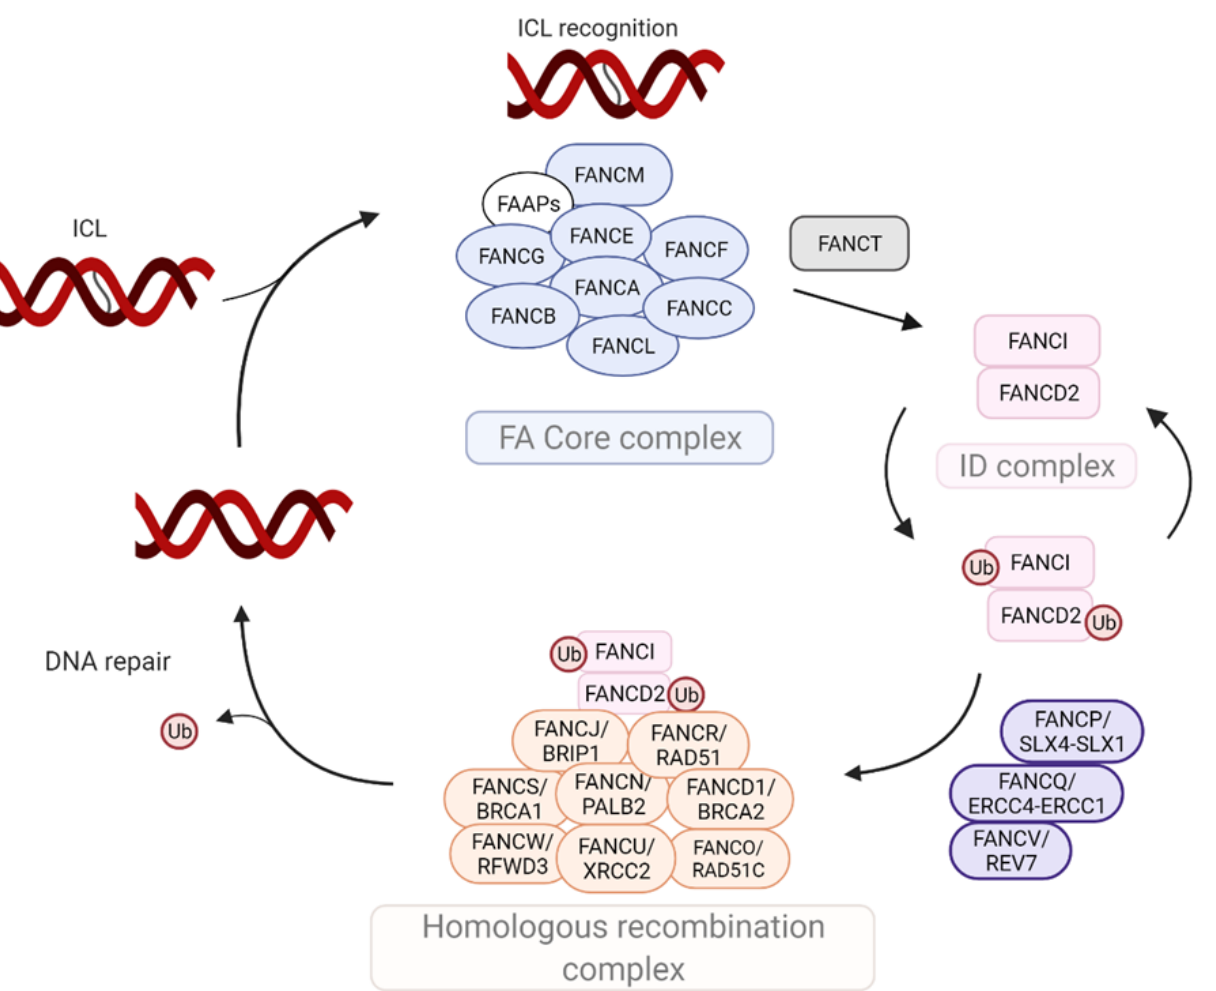
Figure 1. The Fanconi anemia (FA) DNA repair pathway specializes in the repair of DNA interstrand cross-links (ICLs). The FA pathway is activated in response to ICL formation. ICLs are recognized by the FANCM protein, which subsequently recruits the FA core complex to chromatin. The FA core complex is a ubiquitin E3 ligase composed of eight FA proteins (FANCA, FANCB, FANCC, FANCE, FANCF, FANCG, FANCL, FANCM; blue circles) as well as FA associated proteins (FAAPs) (white circle). The FA core complex monoubiquitinates the FANCD2:FANCI complex (pink rectangles) in conjunction with the E2 conjugating enzyme FANCT (green rectangle). The activated FANCI:FANCD2 (ID) complex then allows the recruitment of translesion synthesis and homologous recombination complex proteins (orange and purple ovals) to complete DNA repair. Silver spiral strand: interstrand cross link in the DNA double helix. Arrow: activation. FANCS/BRCA1: Breast cancer susceptibility protein 1; FANCN/PALB2: Partner and localizer of BRCA2; FANCJ/BRIP: BRCA interacting protein; FANCW/RFWD3: ring finger and WD repeat domain protein; FANCU/XRCC2: X-ray repair cross complementing protein; FANCP/SLX4: structure-specific endonuclease subunit; FANCD1/BRCA2: Breast cancer susceptibility protein 2; FANCO/RAD51C: Fanconi anemia, complementation group O; FANCR/RAD51: Fanconi anemia, complementation group R; FANCV/REV7: Fanconi anemia, complementation group V; FANCQ/ERCC4: Excision repair, complementing defective, in Chinese hamster, 4. Available online: https://biorender.com/illustrations (accessed on 11 March